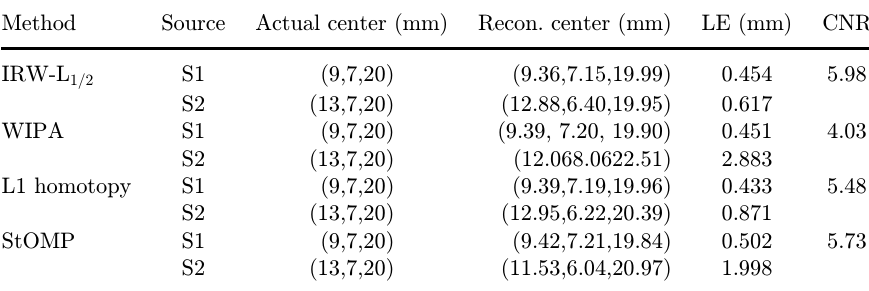
Table 4. Quantitative reconstruction results in double-sources